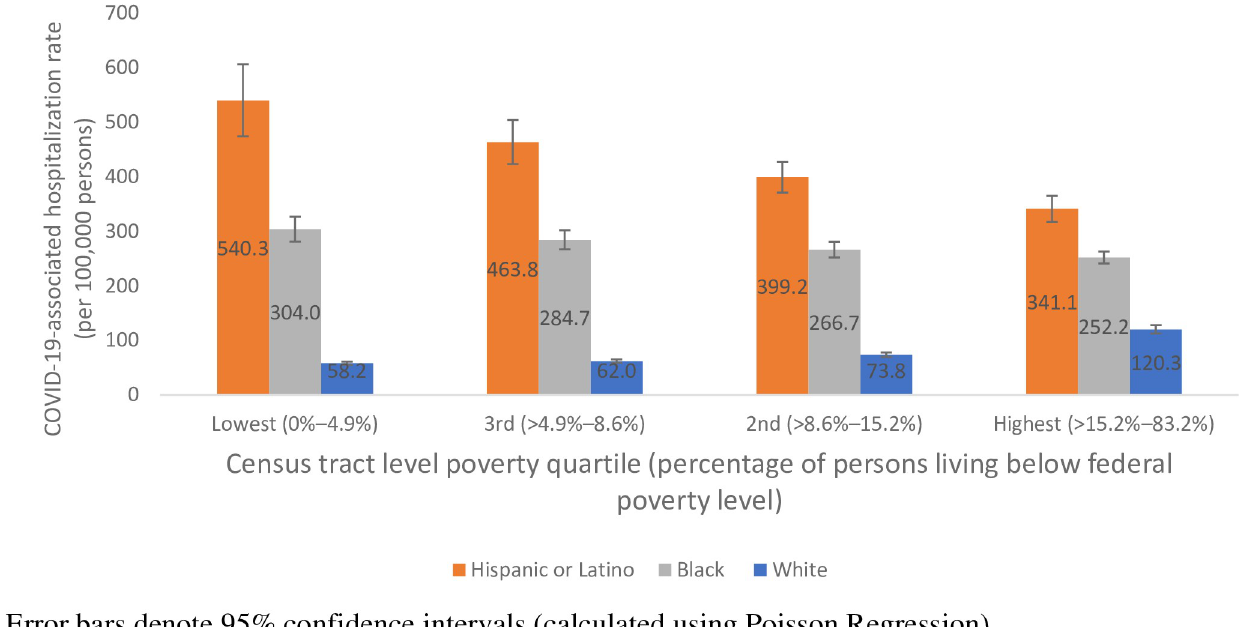
Fig 3. Age-adjusted COVID-19-associated hospitalization rates by census tract-level poverty strata (quartiles) and race/ethnicity—COVID-NET catchment areas in 14 states, March–April 2020.